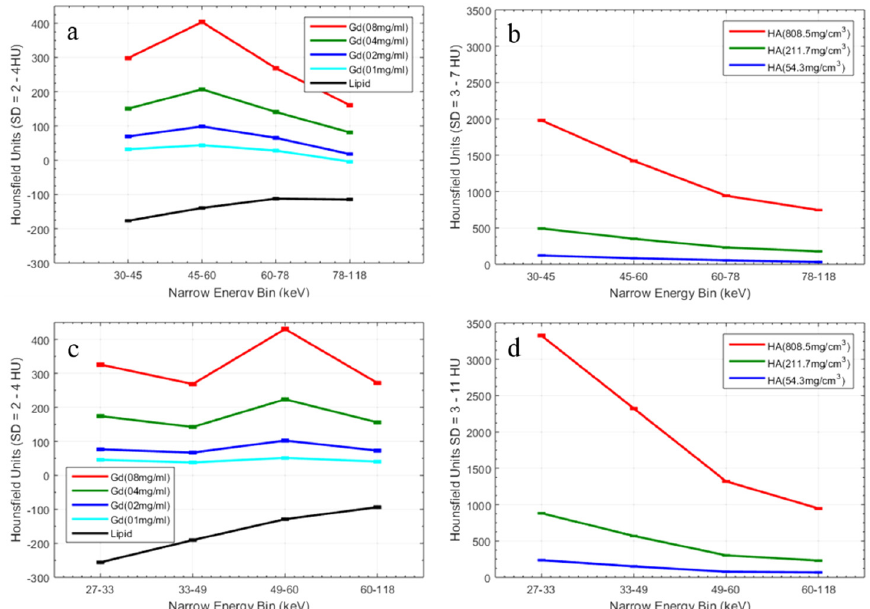
Figure 6. Spectroscopic HU of gadolinium, lipid and hydroxyapatite across different energy bins with protocol-1 ( a , b ) and protocol-2 ( c , d ).